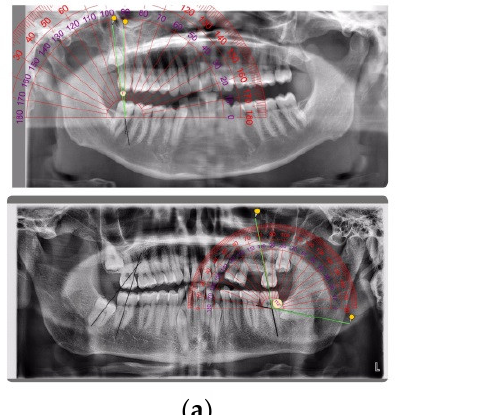
Table 1. Distribution of the number and ratio of the patients’ gender.